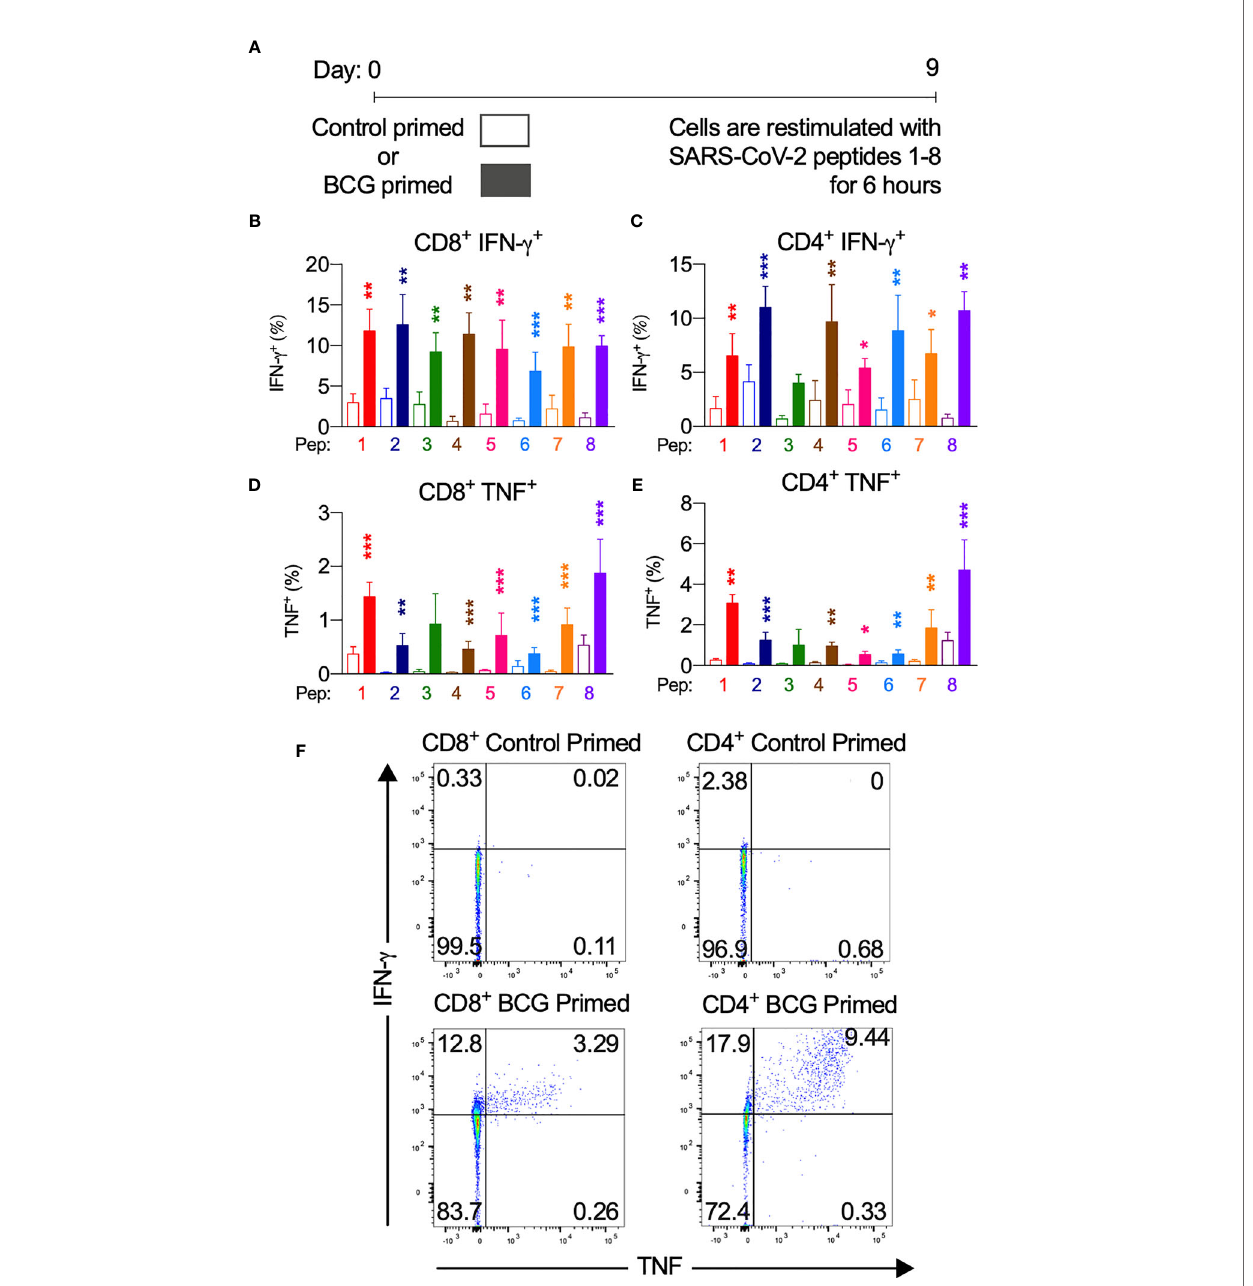
FIGURE 3 | BCG priming enhances SARS-CoV-2 T cell responses. BCG-peptide-primed T cells restimulated with SARS-CoV-2-peptide-pulsed DCs analysed by fl ow cytometry. Unshaded bars- Control primed (irrelevant peptide, PVSKMRMATPLLMQA), then SARS-CoV-2-peptide1-8 restimulated. Shaded bars – BCG peptide 1-8 primed then SARS-CoV-2-peptide homologue restimulated. (A) Brief culture timeline, (B) CD8+IFN- g + responses ( n = 9-12), (C) CD4+IFN- g + responses ( n = 5-13), (D) CD8+TNF+ responses ( n = 4-14), (E) CD4+TNF+ responses ( n = 6-16), (F) Representative TNF (x-axis) and IFN- g (y-axis) dot plots of a responder donor with their corresponding SARS-CoV-2 primary response control. * P <0.05, ** P <0.01,*** P <0.001 by Wilcoxon-matched-pairs-signed-rank test, comparing magnitude of response to SARS-CoV-2 peptides with or without BCG